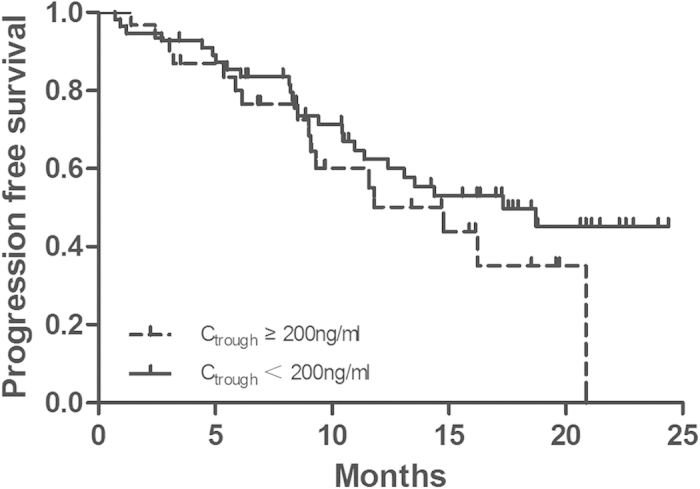
PFS of patients with Ctrough < 200 ng/ml (solid line) or Ctrough ≥ 200 ng/ml (dashed line).